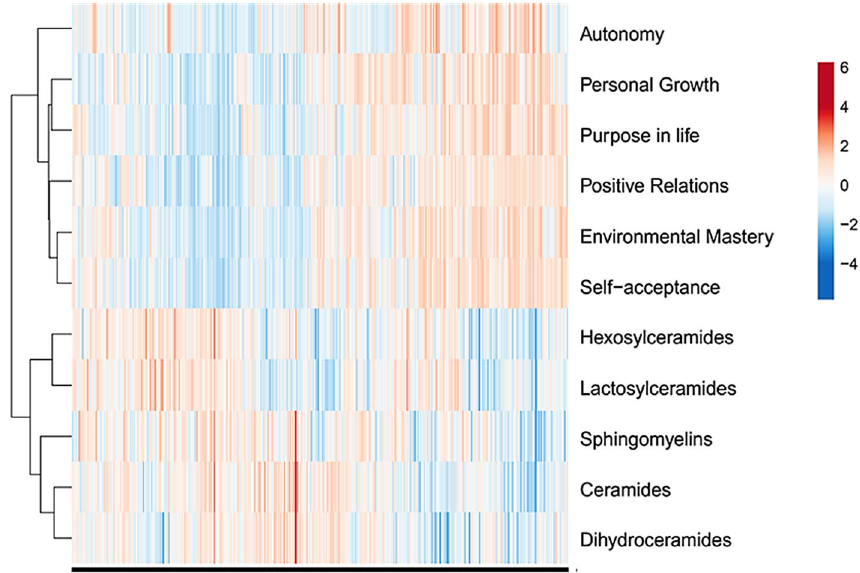
Figure 2. Hierarchical clustering heatmap of subjects from MIDUS, based on PWB dimensions and sphingolipid levels. Columns represent individual participants. Rows represent sphingolipid classes and PWB dimensions. A three-color scale was used with blue indicating low relative values, white indicating average values, and red representing high relative values. This heatmap was performed using the web tool ClustVis 2.0 (https:// biit. cs. ut. ee/ clust vis).